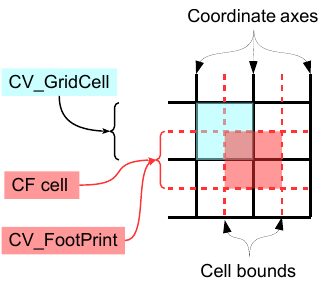
Figure 13. The relationship between ISO grid cells and footprints, and CF cells described by cell